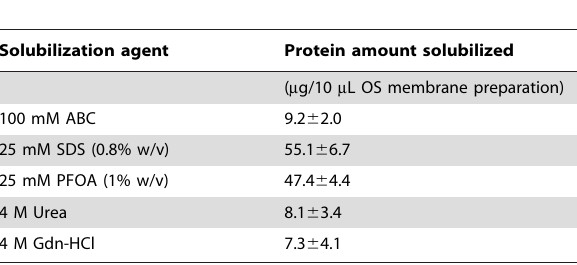
Table 1. Solubilization of membrane proteins by different reagents.